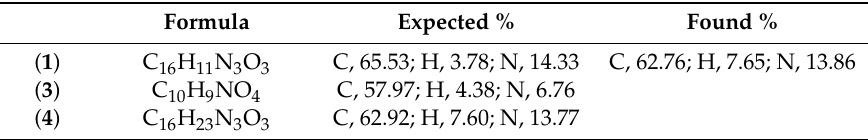
Table 1. Comparison of formula to published elemental analysis.